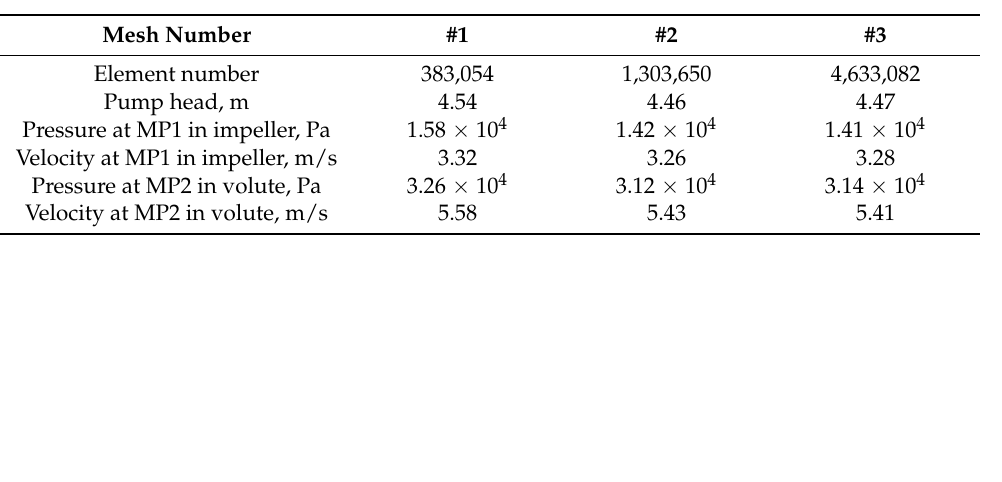
Table 2. Comparison of the simulated results from different